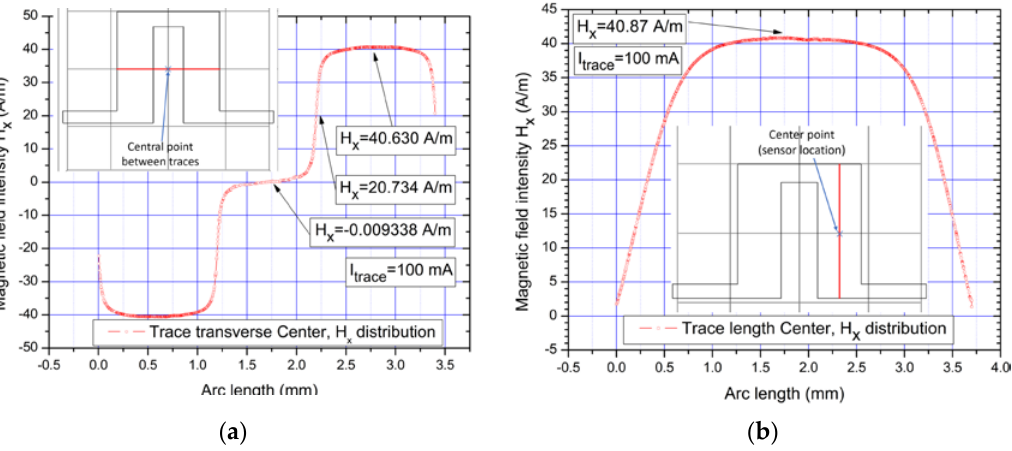
Figure 18. Magnetic field intensity on the x direction, variation for the U-shaped trace at height h = 45 μm according to results from COMSOL simulation: ( a ) transverse center line (note the inset); ( b ) longitudinal center line (note the inset).